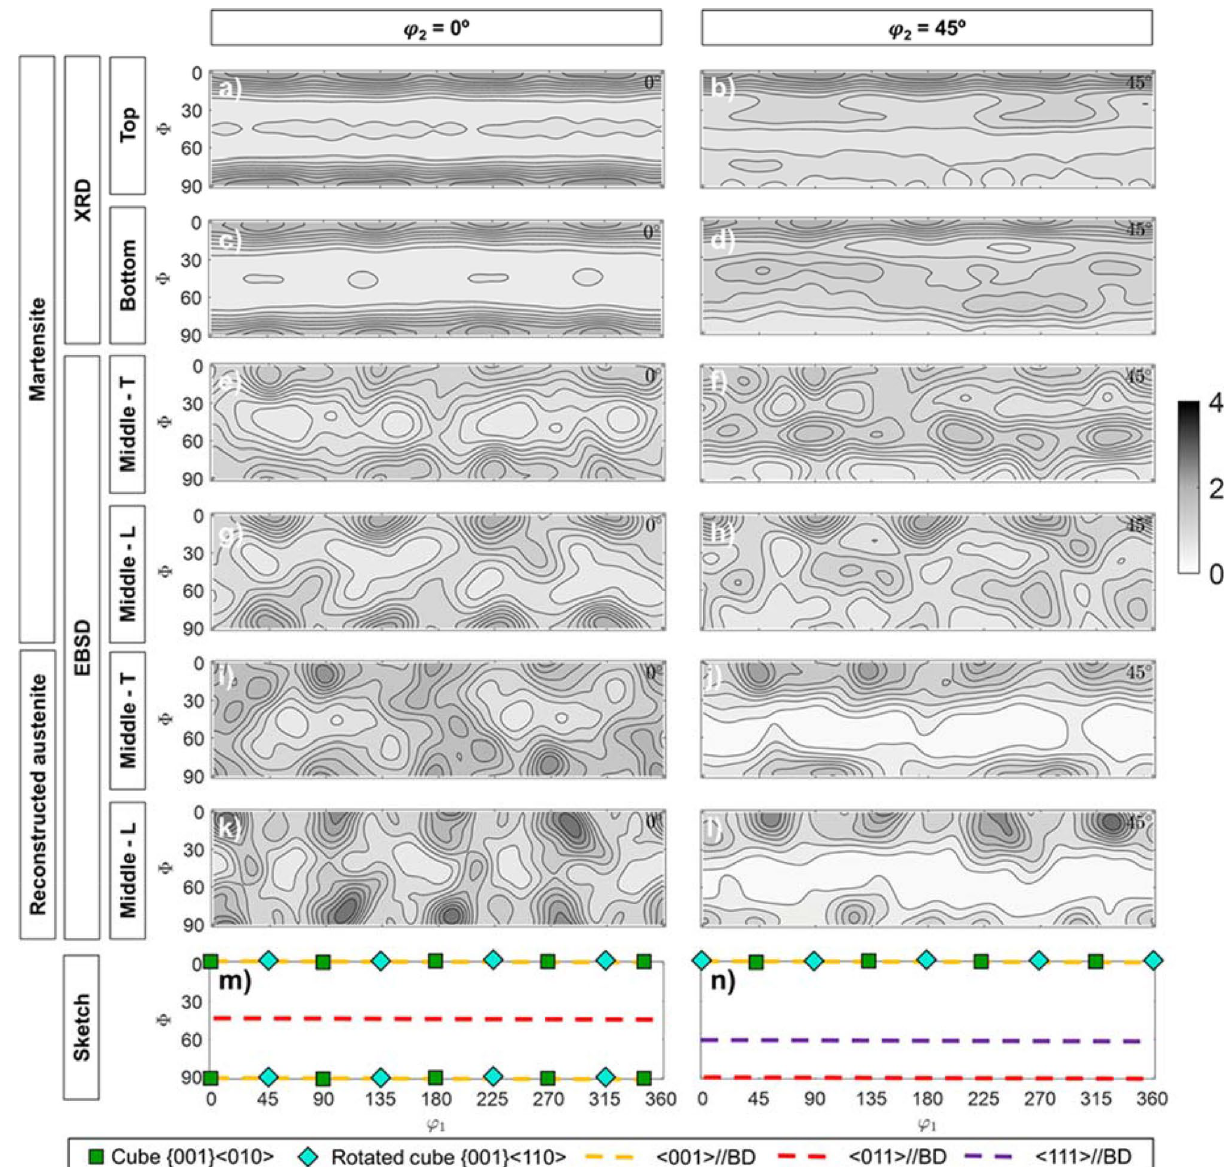
Figure 5. ( a , c , d , g , i , k , m ) ϕ 2 = 0° and ( b , d , f , h , j , l , n ) ϕ 2 = 45° ODF sections corresponding to the martensitic matrix of the middle ( e – l ), top ( a , b ) and bottom ( c , d ) layers of the samples and to a sketch depicting some important texture components or textures that are named in the main text ( m , n ). Data corresponds to martensite data measured on the EOS—40 μm—CW laser condition by ( a – d ) XRD and ( e – h ) EBSD (transverse T and longitudinal L sections) and to reconstructed austenite data obtained from the EBSD data ( i – l ). Intensities correspond to the color bar on the right-hand side, where the units are multiples of random distribution